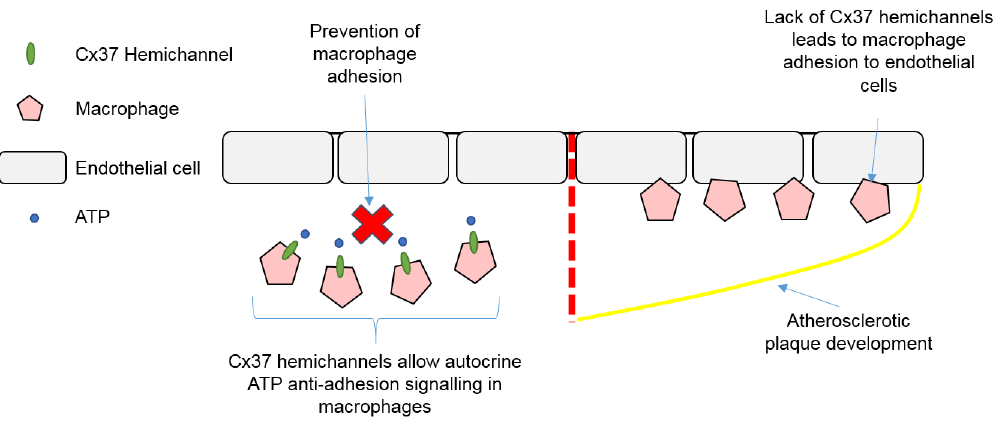
Figure 3. Autocrine ATP signalling via connexin 37 hemichannels prevents macrophage adhesion to endothelial cells. Yellow line = atherosclerotic plaque border. Abbreviations: Cx = Connexin. ATP = Adenosine